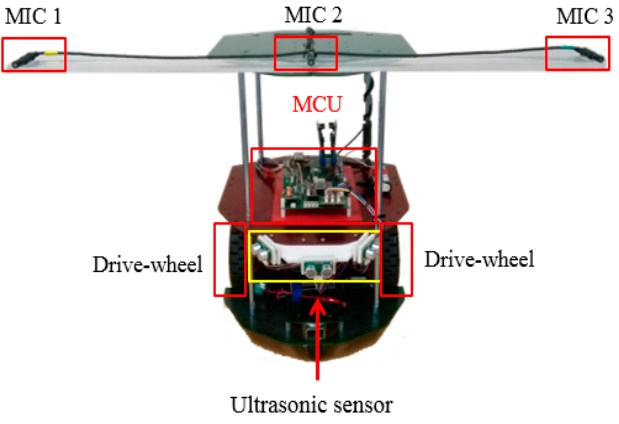
Figure 9. Components of the experimental mobile robot (slave robot). Table 6. Hardware specifications of the mobile